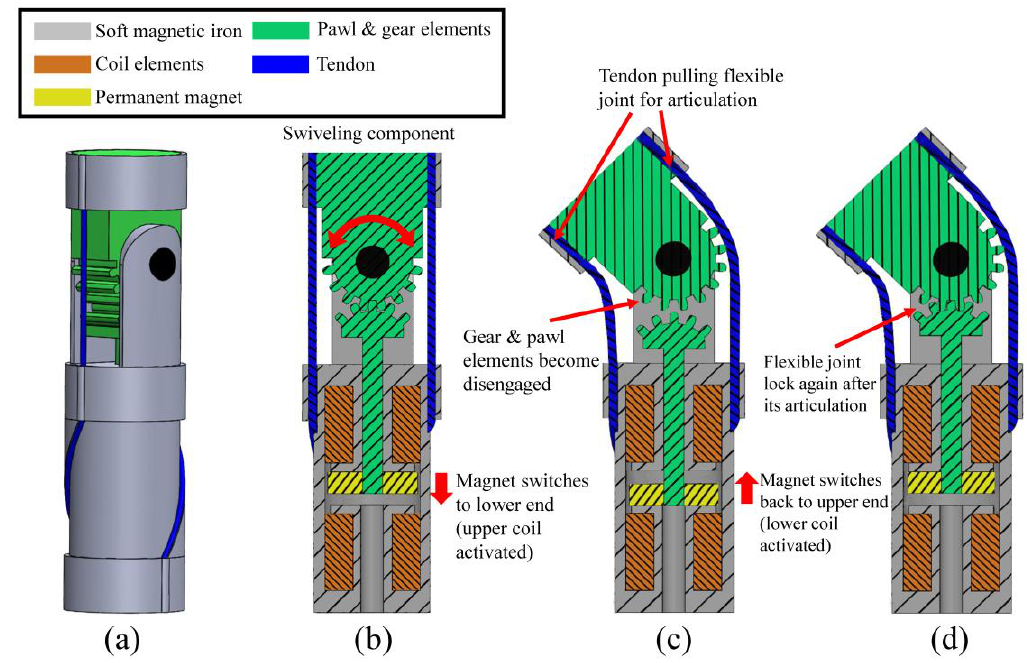
Figure 2. Working principle of the electromagnetic structure. ( a ) Isometric view of one actuator. ( b ) Cross-sectional view of the actuator in the locking position. ( c ) The gear and pawl elements become disengaged, while the swiveling joint rotates by the tendon-driven structure. ( d ) The swiveling joint locks again after the desired angulation achieved.